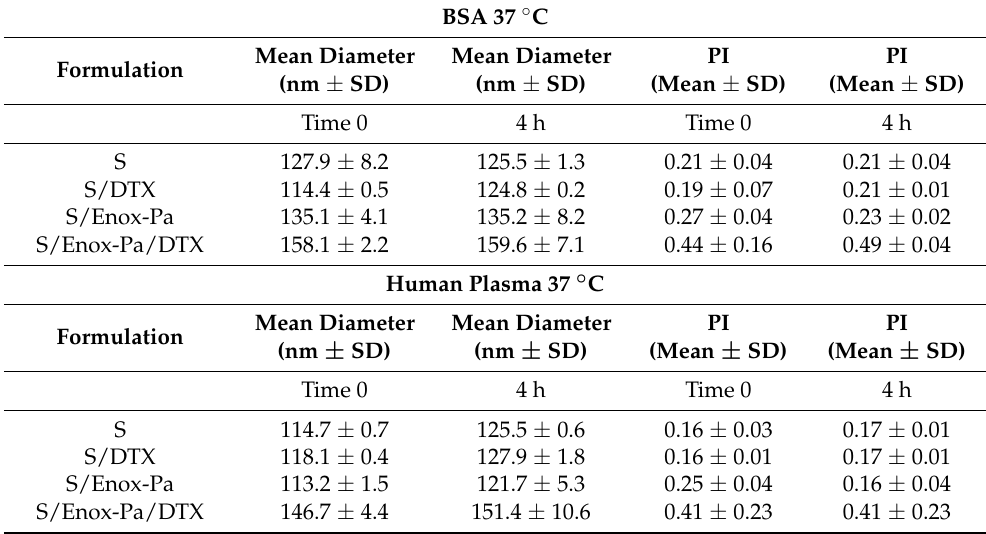
Table 2. Size and PI of SEDDS formulations following incubation in serum albumin (1% w / v ) or in plasma (1:100 dilution in phosphate buffer) at time zero and after 4 h at 37 ◦ C. Values are reported as mean ± SD (n = 3).